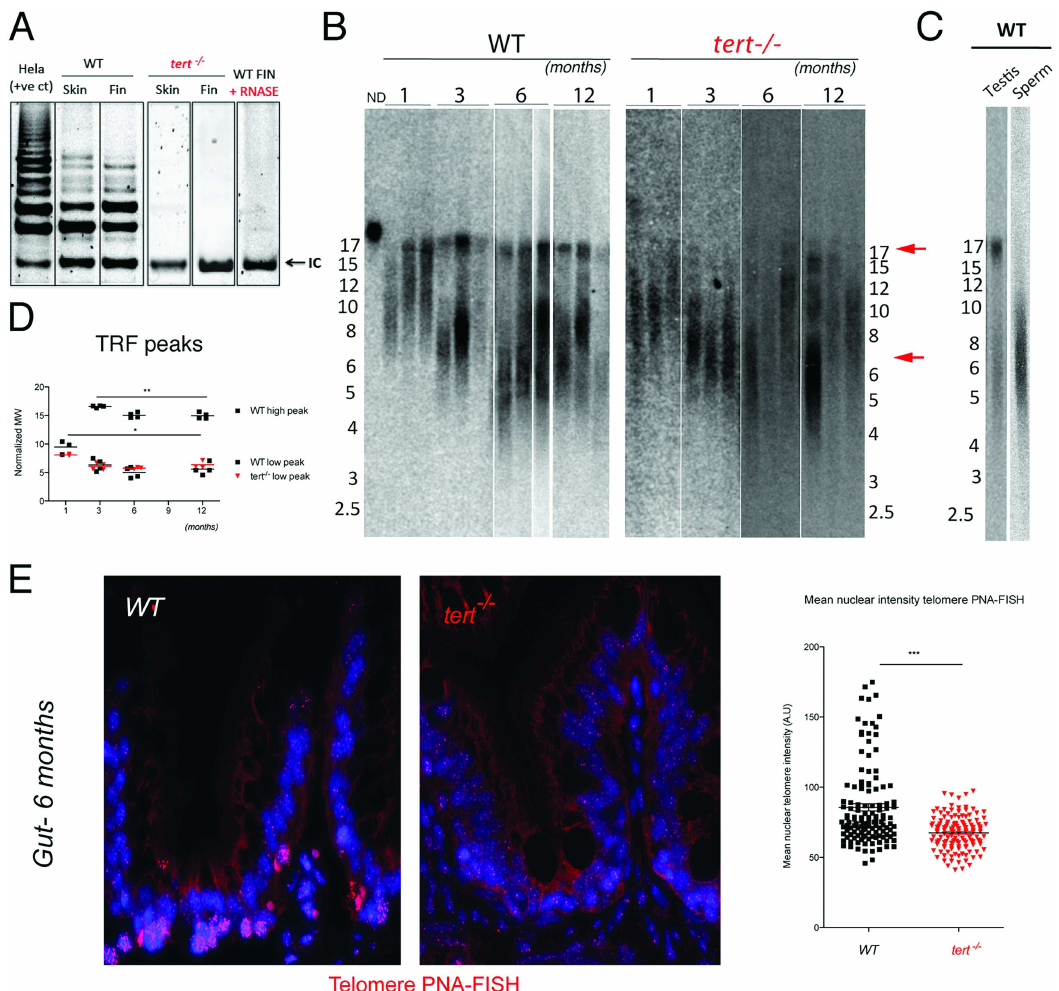
Fig 1. Telomerasemutant zebrafish have shorter telomeresthan WT siblings. A) Representative image of TRAP assay showingthat telomerase is not active in the tert − / − zebrafish, as comparedto tert +/+ siblings. Here shown are caudal fin and skin protein extracts. Hela cell extract is shown as positive control. N = 4. B) Representative image of restriction fragment analysisof caudal fin genomic DNA of 3 different individualsat different ages, by southernblot (random